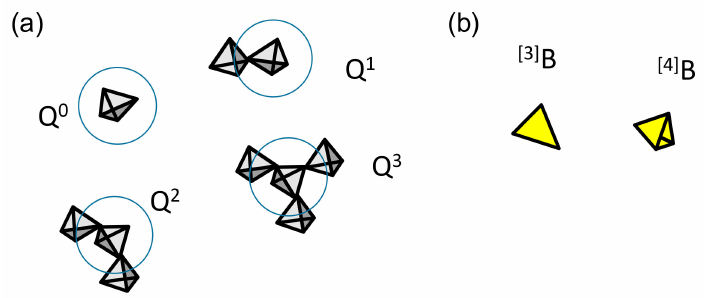
Figure 2. ( a ) Phosphate and ( b ) borate speciation in simple network glasses.